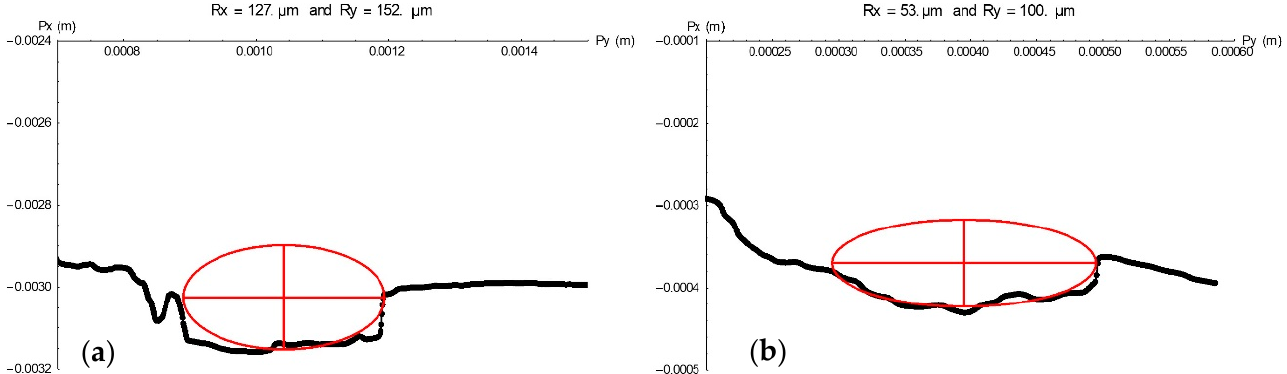
Figure 5. Pit profiles for specimen E12 ( a ) and E21 ( b ) as determined by plotting Py (pit half-width) against Px (pit depth) values.